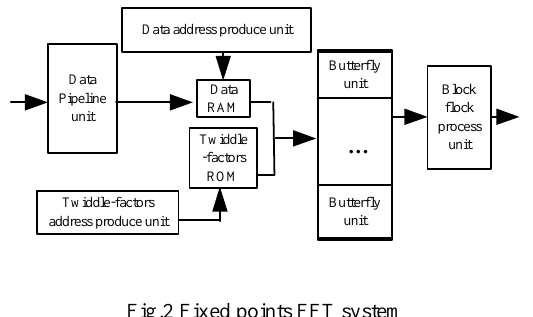
Fig.2 Fixed points FFT system Fig.3 Variable points FFT